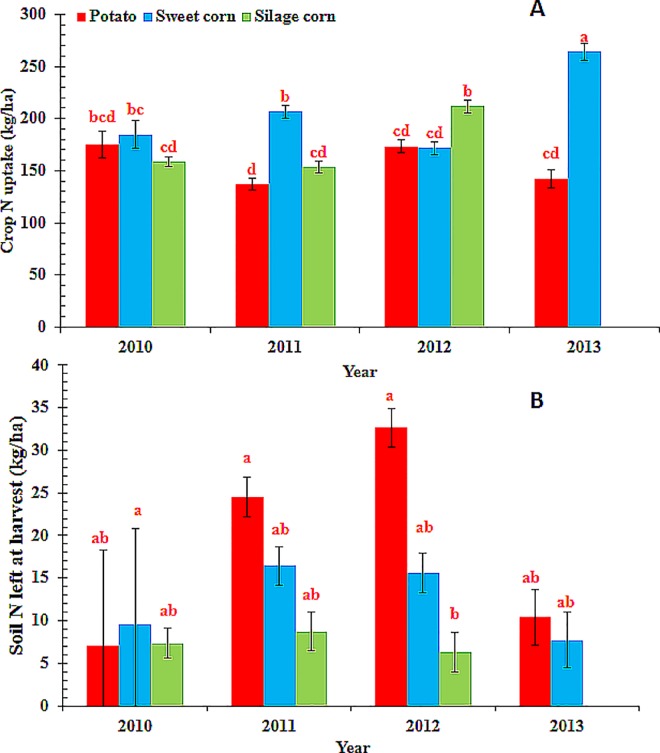
Comparison of A) Nitrogen uptake (Ncrop) and B) mineral N remaining in soil after crop harvest (Nsolfi) between three crops (potato, sweet corn and silage corn) and four growing seasons (2010to 2013) at the study farm in the Middle Suwannee River Basin, Florida. Silage corn was studied only between 2010 and 2012. Mean values of Ncrop and Nsoilfi (represented by individual bars and their standard errors for the three crops) followed by different letters indicate significant difference at α = 0.05 level.